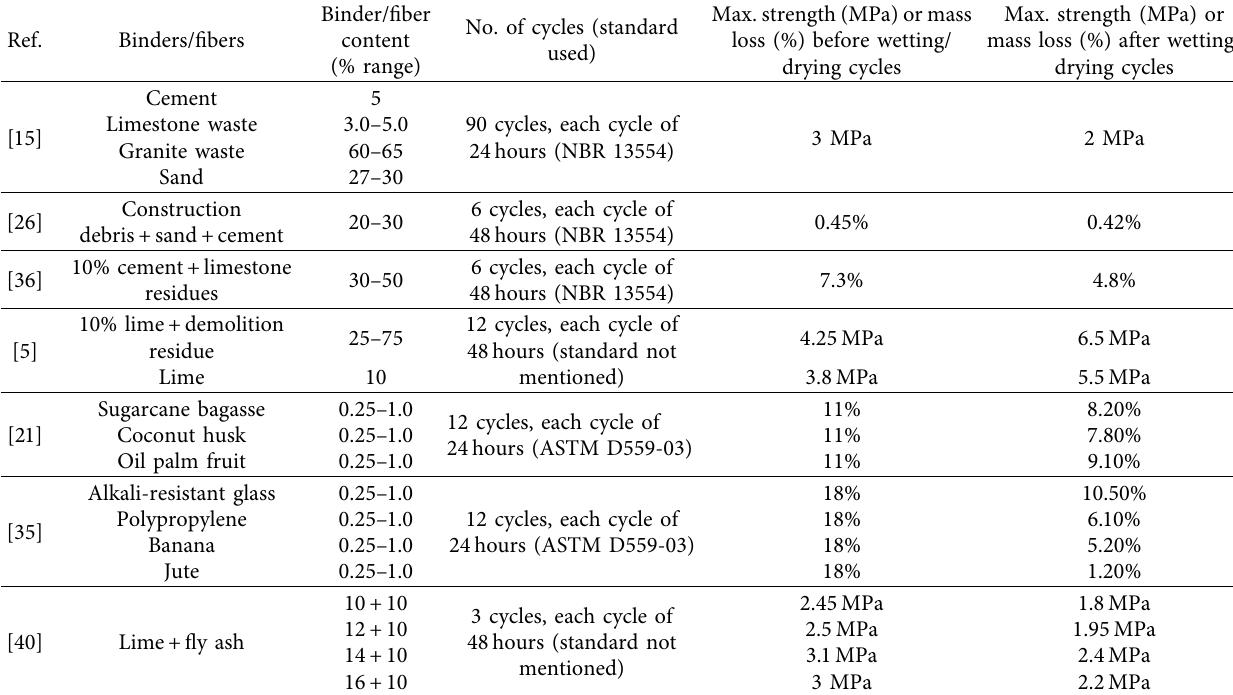
Table 13: Durability by wetting/drying cycles of unfired admixed soil blocks as reported in the reviewed articles.